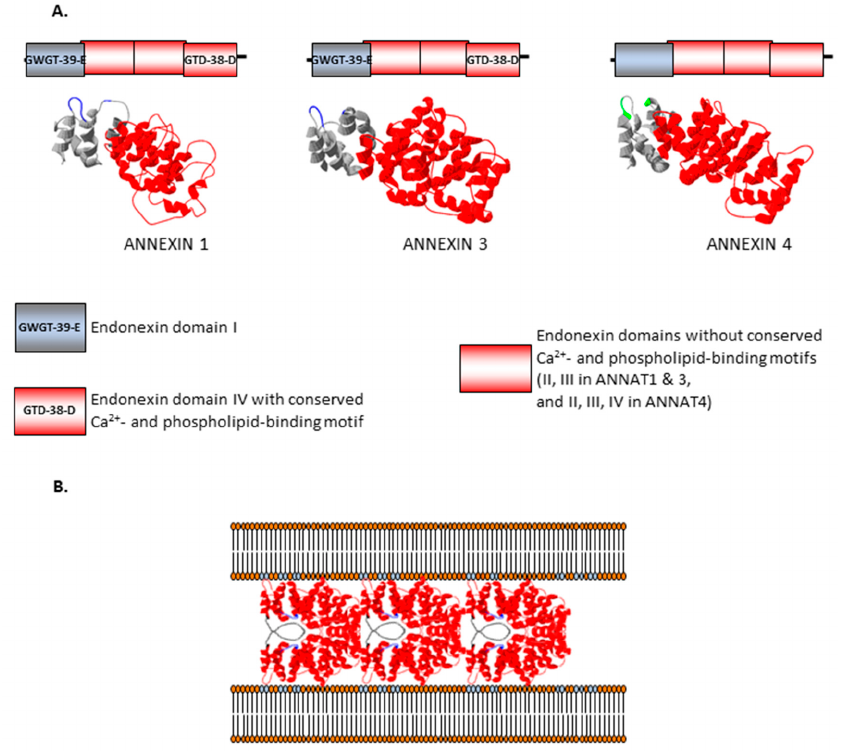
Figure 1. Predicted structure of three Arabidopsis annexins and proposed mechanism for annexin-membrane coordination. ( A ) Predicted structure of three Arabidopsis annexins,